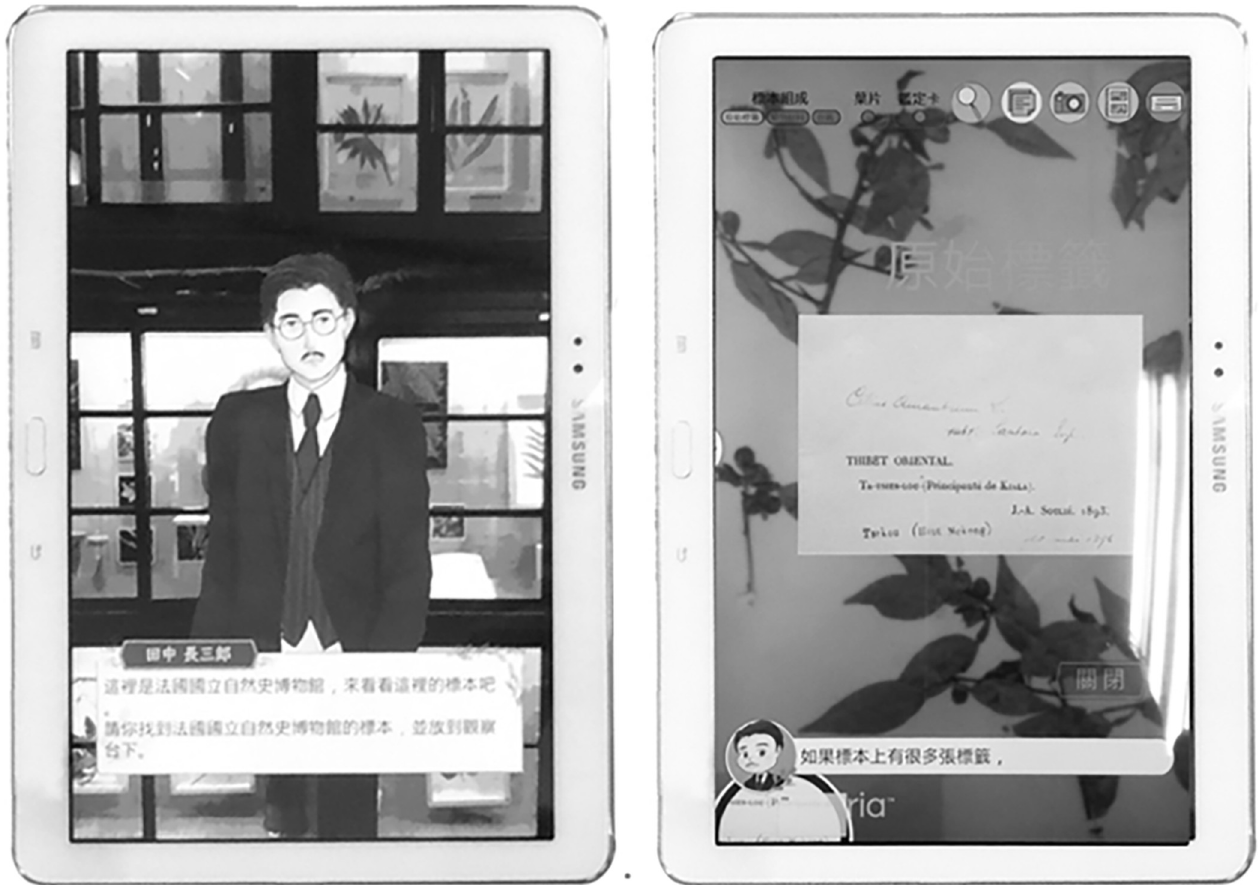
Fig 2. User view of the AR exhibit in a real-world context. Note: The authors created this figure for this article; it is not based on any previously copyrighted image. The authors created the images on the screen of the tablet in this figure.